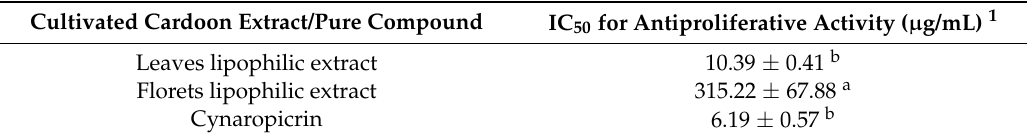
Table 1. IC 50 values of cultivated cardoon lipophilic extracts and cynaropicrin on the 48 h cellular viability of MDA-MB-231 cells, by using the MTT